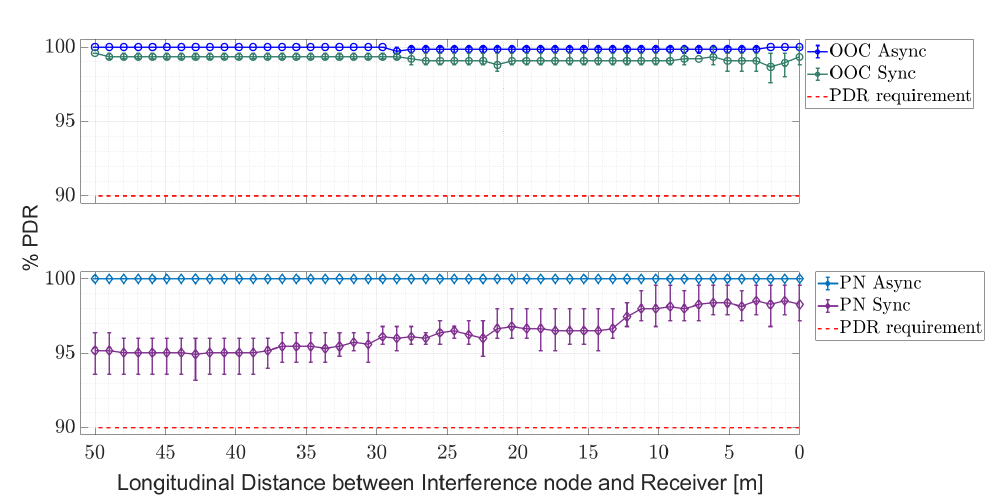
Figure 16. PDRperformancecomparisonbetweenPNandOOCOCDMAforasynchronouscommunications.